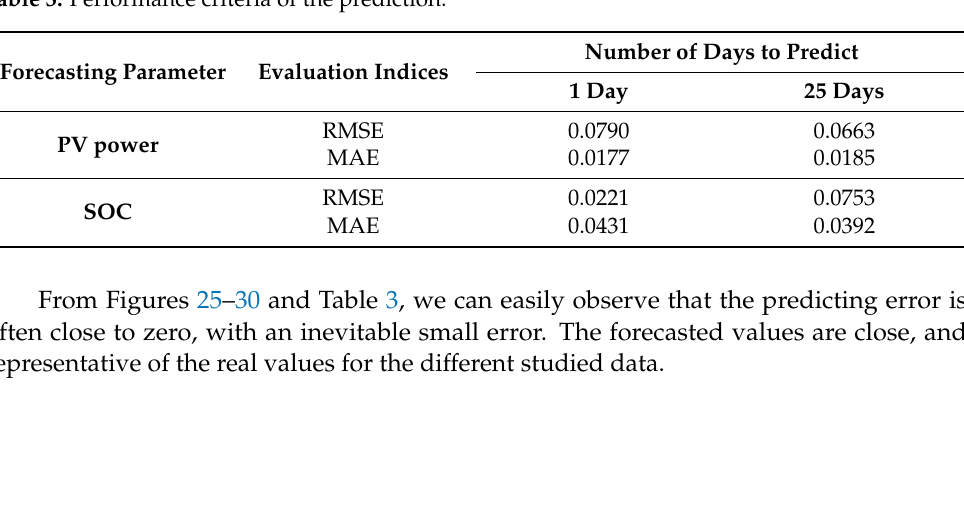
Table 3. Performance criteria of the